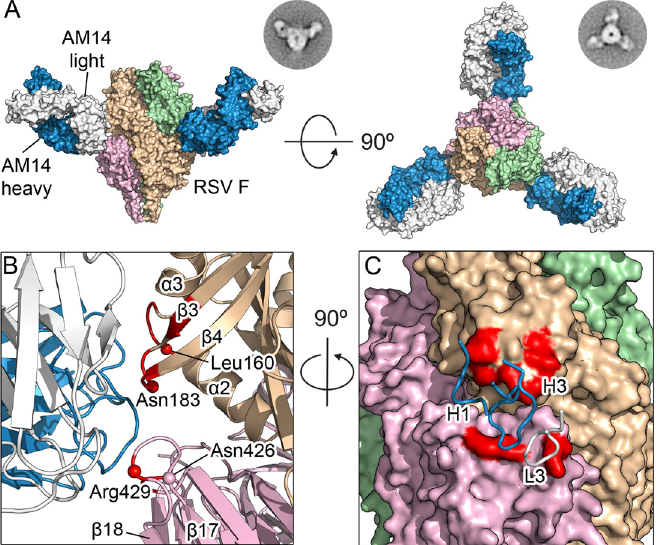
Fig 2. Structures of AM14 in complex with RSV F. (A) Crystal structure of three AM14 Fabs bound to the prefusion RSV F trimer, viewed from the side and the top of RSV F. Negatively stained EM class averages that may correspond to each view are shown in the upper right. AM14 heavy chain is blue, light chain is white, and RSV F protomers are tan, light green and pink (B) Close-up of the side view, colored as in (A). Prefusion RSV F residues with C α atoms within 8 Å of AM14 Fab C α atoms are colored red, and C α atoms of resistance mutations are shown as spheres. (C) Ninety-degree rotation of the view in (B), showing a molecular surface representation of RSV F and the location of the three AM14 CDR loops that contact F. The binding surface spans the two neighboring protomers (tan and pink).